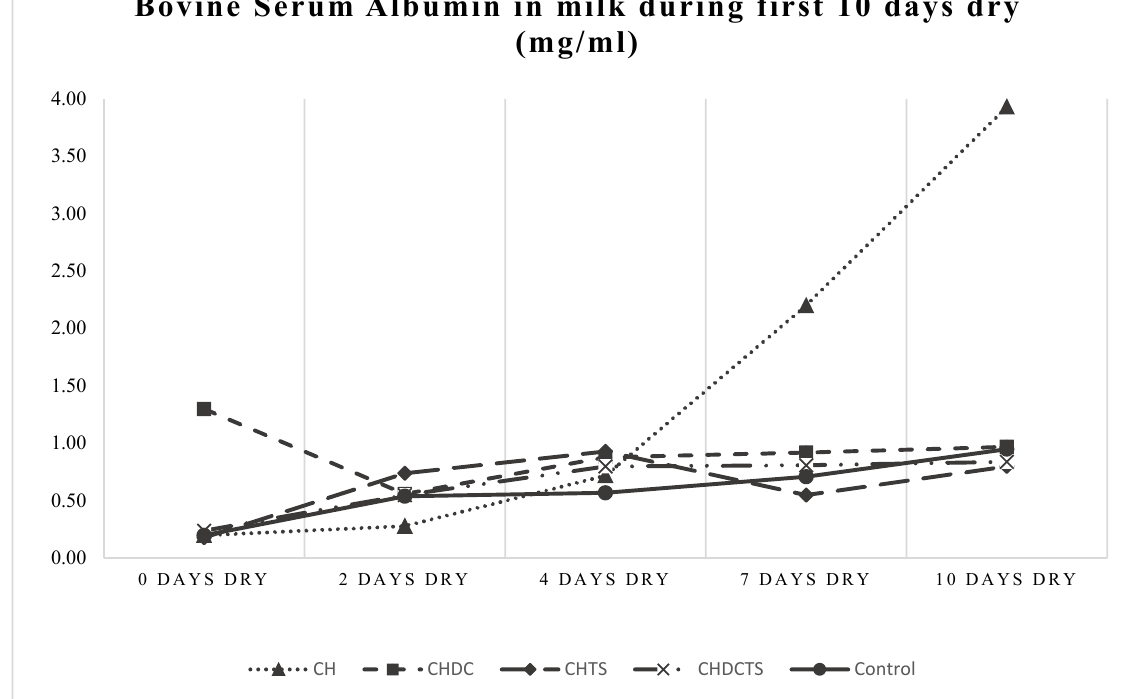
Figure 3. BSA by days dry and treatment group; CH cows differed from CHDC, CHDCTS and control at 10 days dry ( p < 0.05, GLIMMIX). CH = casein hydrolysate; CHDC = casein hydrolysate + dry cow treatment; CHTS = casein hydrolysate + teat sealant; CHDCTS = casein hydrolysate + dry cow treatment + teat sealant; Control = dry cow treatment + teat sealant .